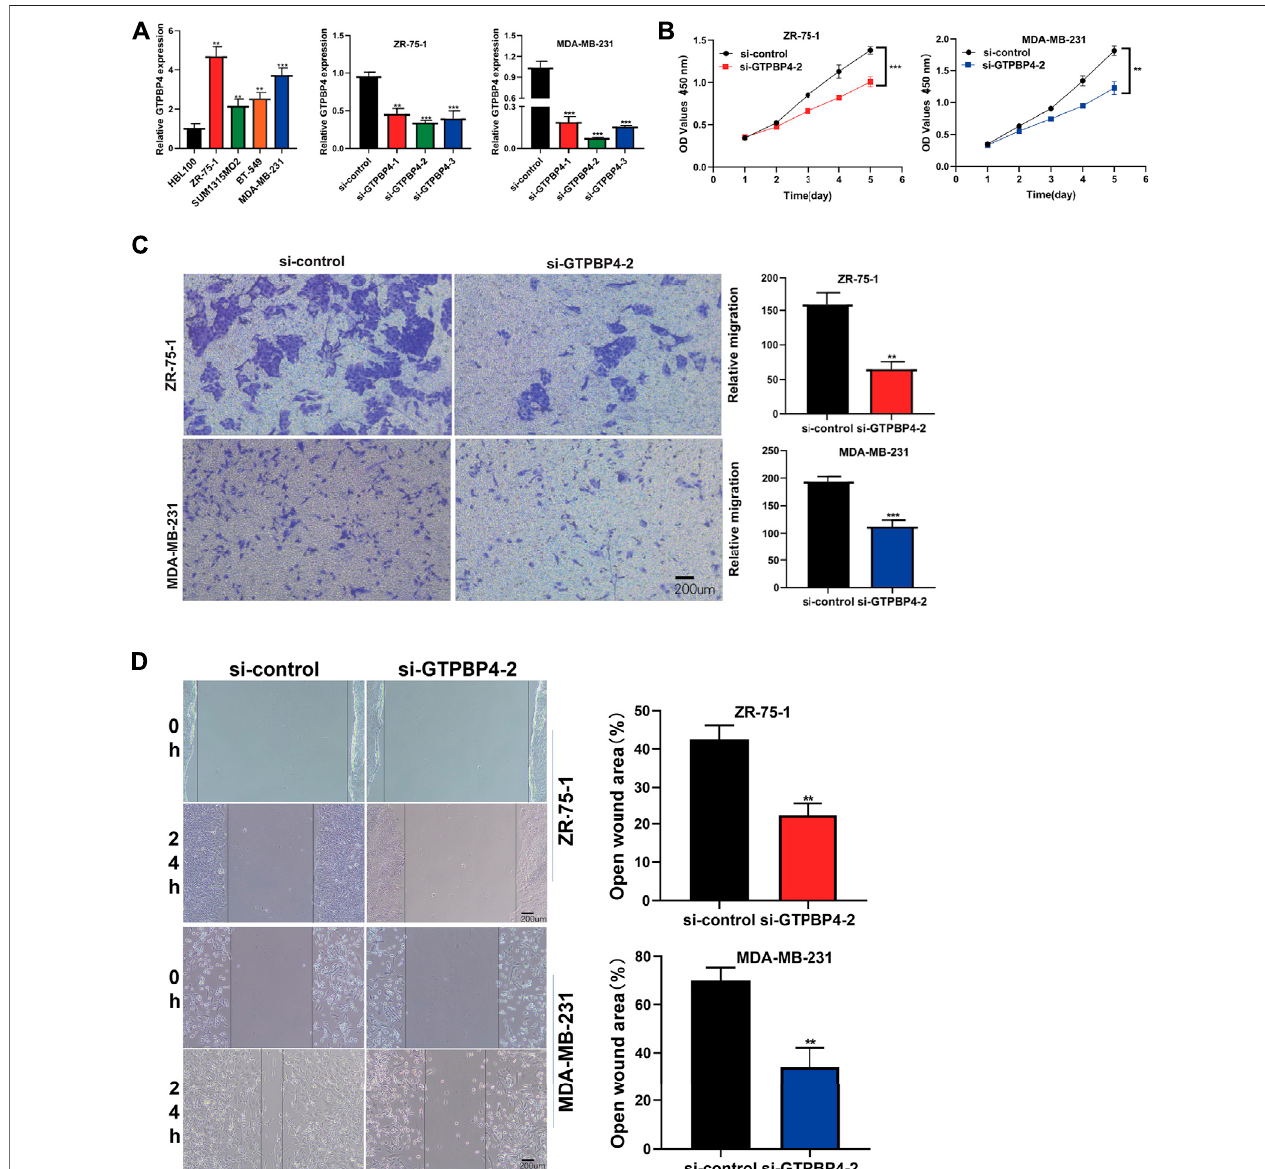
FIGURE9| Cell assaywasperformedtoverify theexpression and functionofGTPBP4inbreastcancercelllines. (A) PCRassayshowedthatGTPBP4 expression was signi fi cantly up-regulated in four breast cancer cell lines ZR-75-1, SUM1315MO2, BT-549 and MDA-MB-231 compared with normal breast cell line HBL100. The expression of GTPBP4 was higher in ZR-75-1 and MDA-MB-231, so the gene knockdown experiment was carried out in ZR-75-1 and MDA-MB-231 cell lines. Three interferingRNAsweretransfected,amongwhichsi-GTPBP4-2hadthehighesttransfectionef fi ciency(* p < 0.05,** p < 0.01,*** p < 0.001). (B) CCK-8assayshowed that a decreased expression ofGTBPBcould inhibit the cell viability ofZR-75-1 and MDA-MB-231 breast cancer cell lines (** p < 0.01, *** p < 0.001). (C) Trasnwell assay showed that the migration capacity of ZR-75-1 and MDA-MB-231 breast cancer cell lines decreased signi fi cantly after GTBPB4 silencing (** p < 0.01, *** p < 0.001). (D) Scratch and Wound Healing assay showed a decreased speed of wound healing upon GTBPB4 gene knockdown (** p < 0.01).